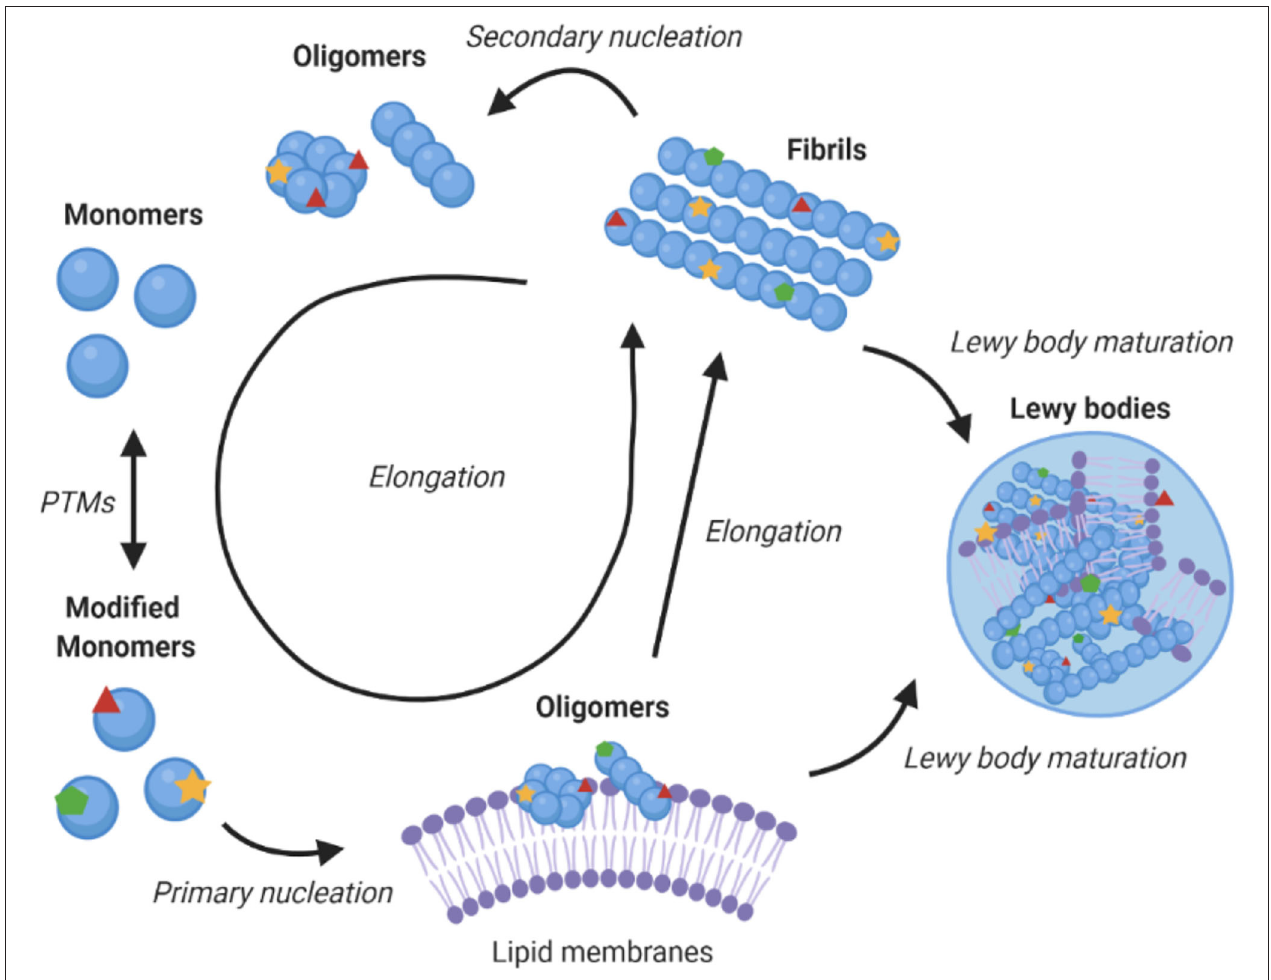
FIGURE 2 | Role of lipid membranes in α -synuclein aggregation and its links with Parkinson’s disease. The figure shows a schematic illustration of a kinetic network model for the aggregation of α -synuclein into amyloid fibrils. Initially, α -synuclein monomers combine to form oligomers, in a heterogeneous nucleation process promoted by lipid membranes ( 43). These oligomers can then either redissolve or mature and elongate into highly structured amyloid fibrils (44). Once fibrils have been formed, secondary processes, including fragmentation and secondary nucleation, accelerate the aggregation process ( 45). Downstream to fibril formation, the mechanism of Lewy body formation and maturation remains to be established, although it is likely to involve interaction of different α -synuclein species with lipid membranes ( 21, 22, 46). The post-translational modifications of α -synuclein can affect essentially all the steps in the aggregation process, including by modulating the binding of α -synuclein to lipid membranes, which may increase the local concentration of α -synuclein and facilitate the initial nucleation events, compared to the slow nucleation rate of free monomers in solution